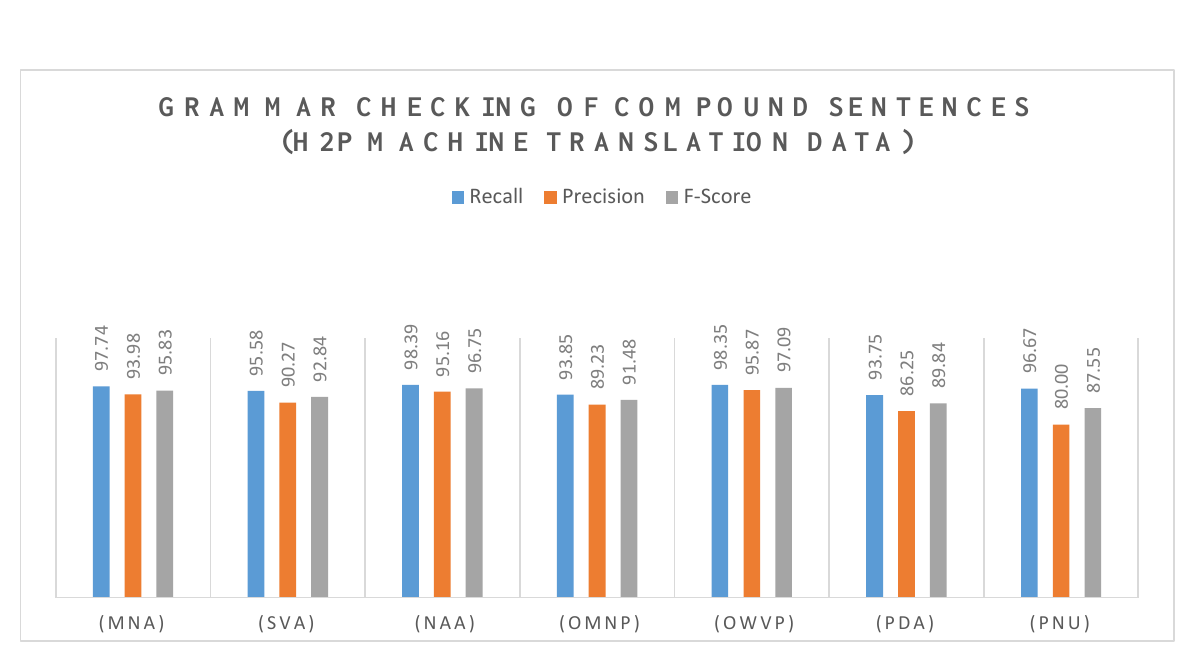
Figure 3.3 : Experimental Evaluation of Grammar checking of compound sentences (Using H2P Machine Translation